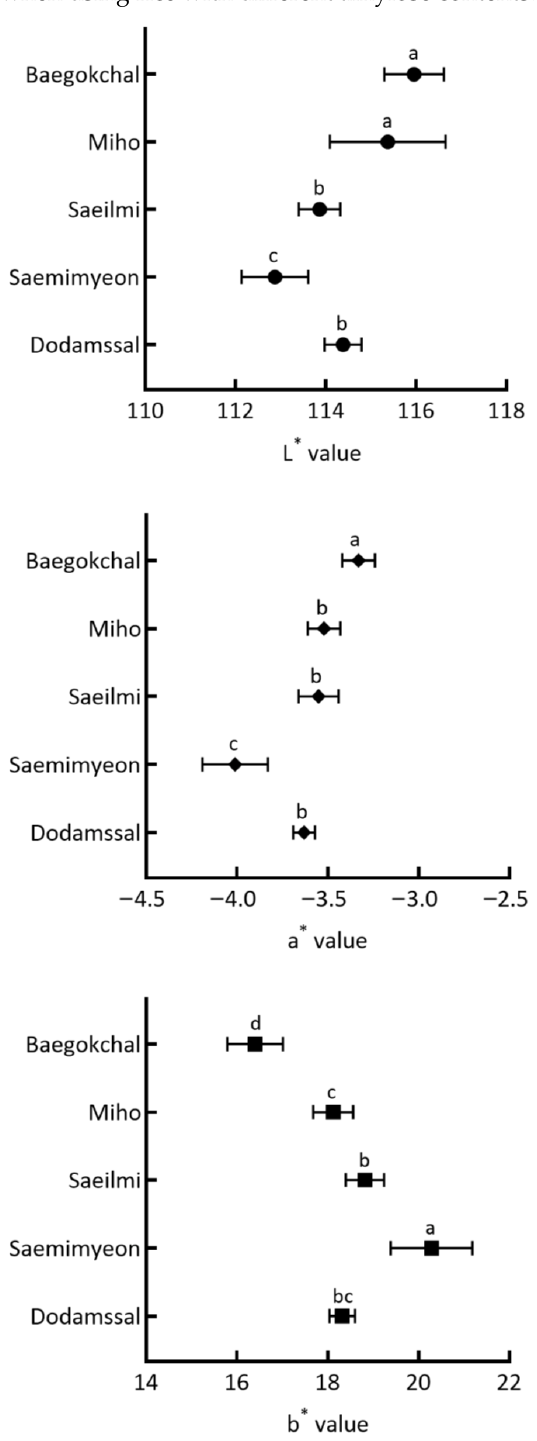
Figure 3. Color value of ice cream made with processed rice. Means with different letters above a bar are significantly different at p < 0.05.